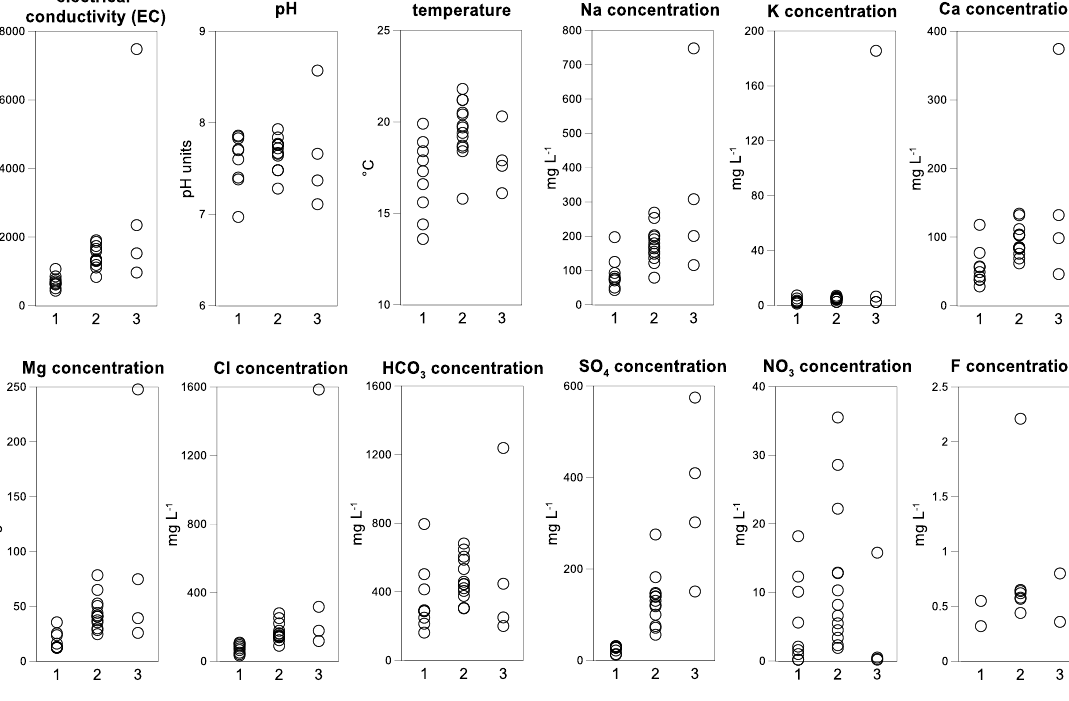
Figure 3. Ranges of selected variables, according to the 3 groups.